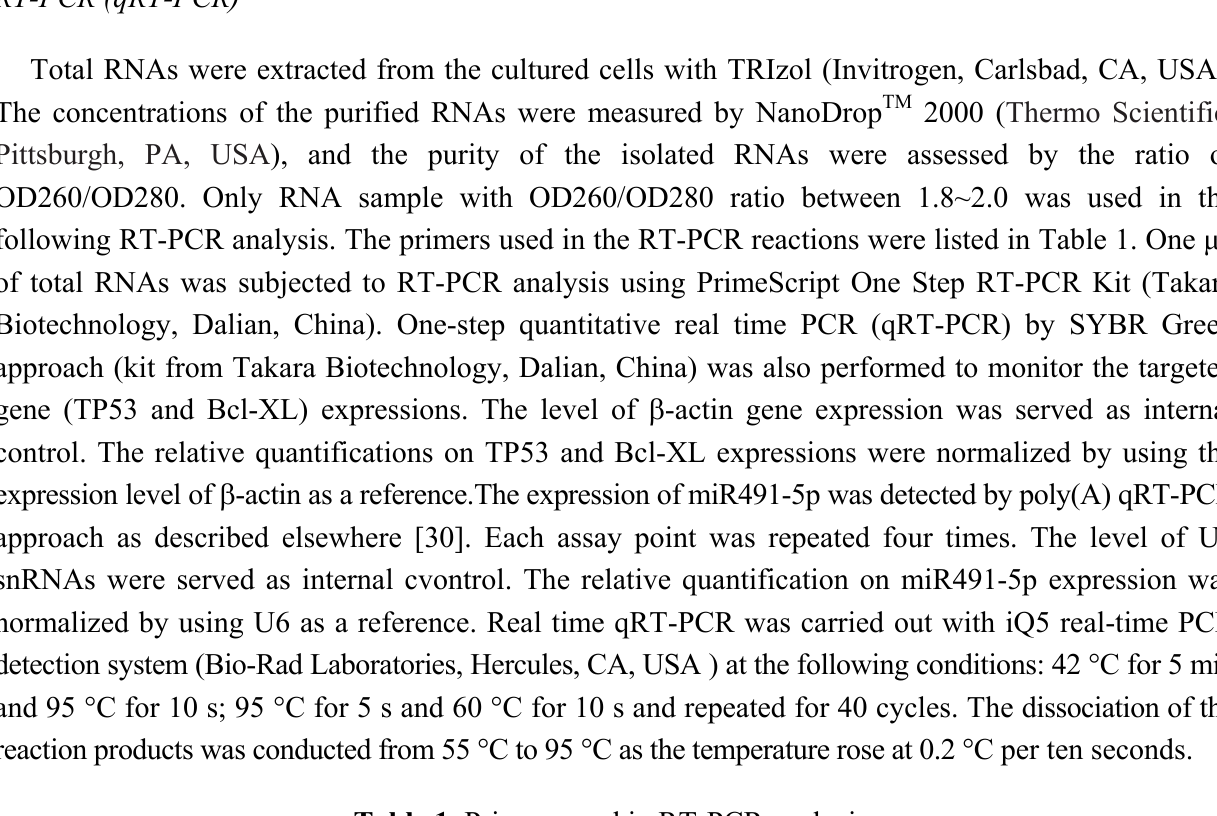
Table 1. Primers used in RT-PCR